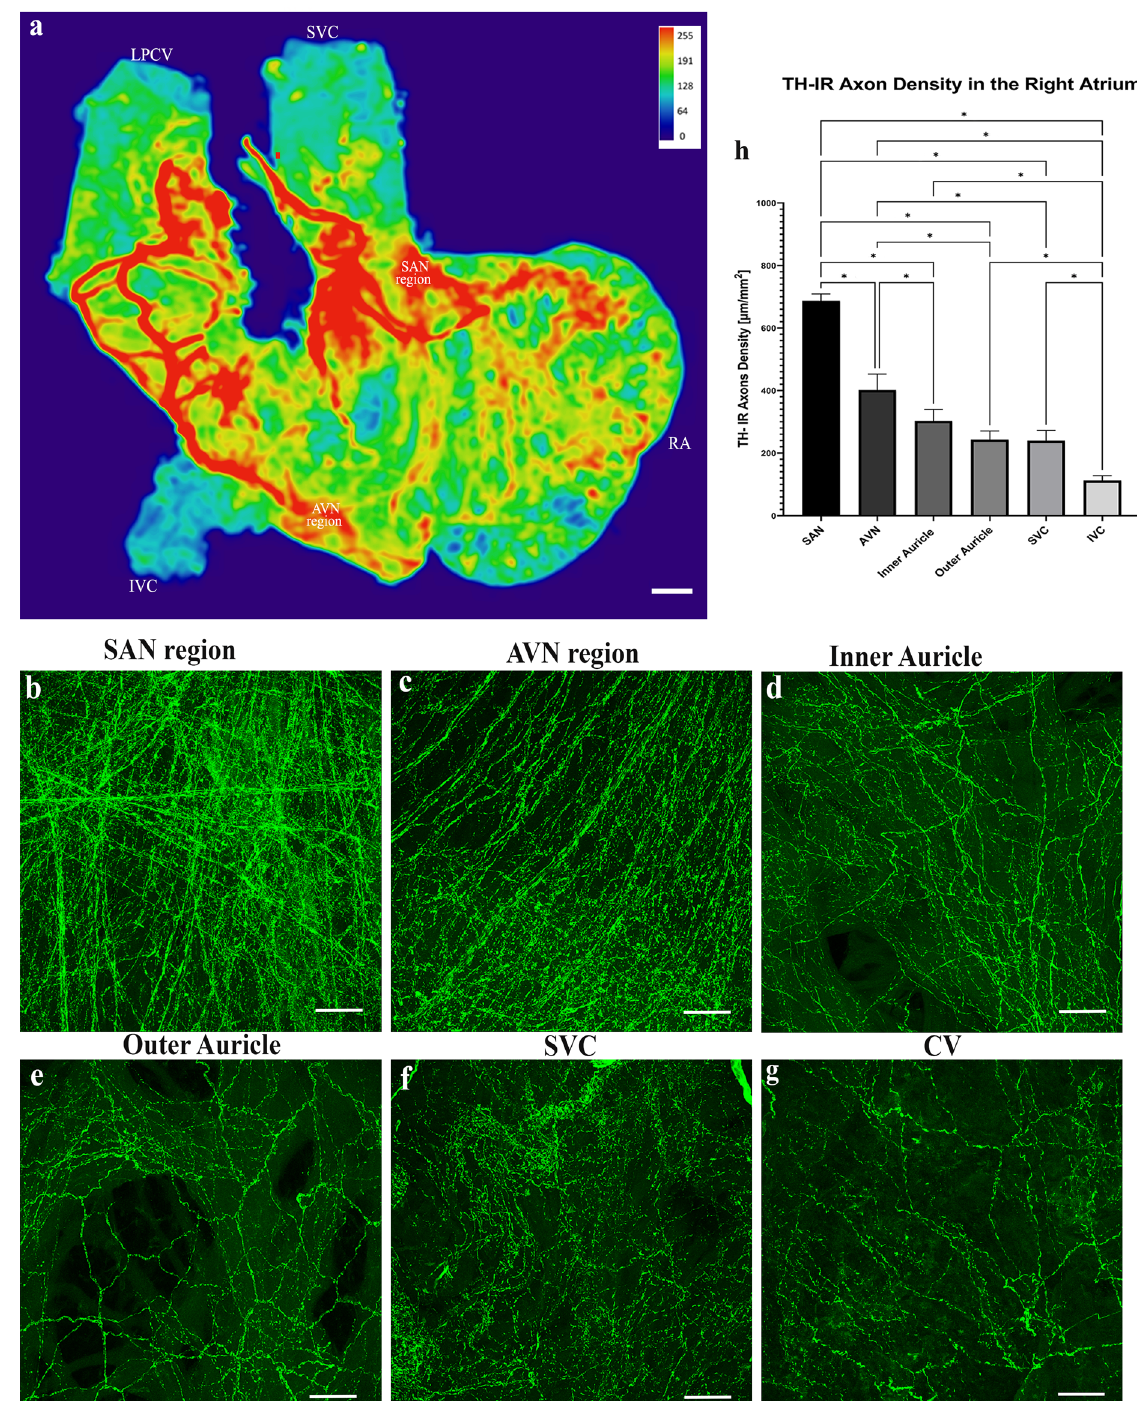
Figure 7. ( a ) Heatmap of the regional density of TH-IR axon innervation in the RA, hot spots are indicated by red color. ( b-g ) Representative images of the regions of interest to show the detailed TH-IR axon innervation in different regions. ( h ) Quantification of TH-IR axons in the RA ROIs of a representative mouse. (Heatmaps were created by Ariege Bizanti with imageJ.1.53t, https:// imagej. net/ softw are/ fiji/). * P < 0.05. n = 6. Scale bars: 500 μm (in ( a )); 50 μm (in ( b-g